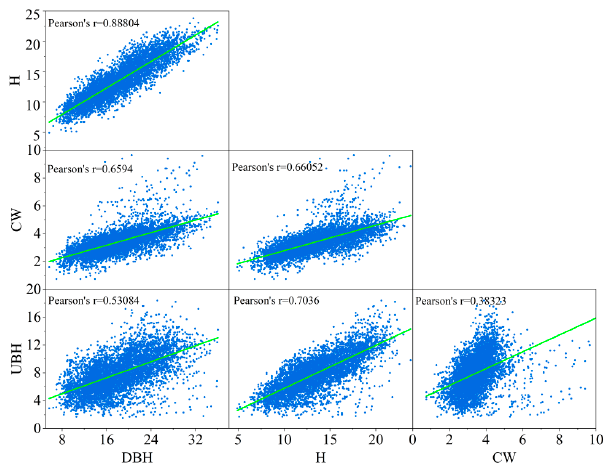
Table 4. Fi tt ing models of Chinese fi r tree height, branch height and crown growth.